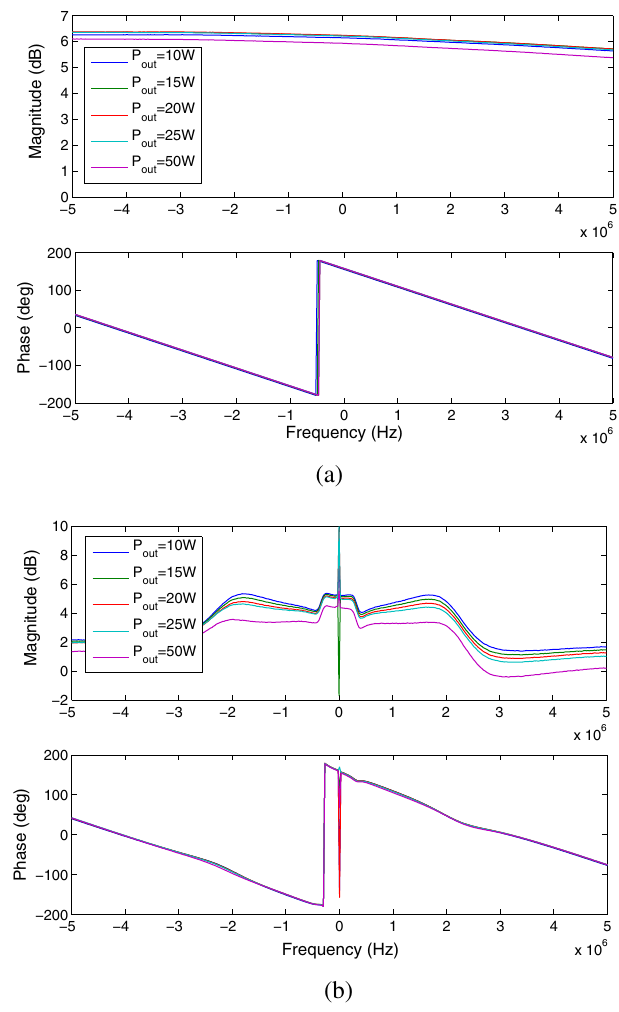
FIG. 14. (Color) Driver transfer functions. (a) Driver amplifier transfer function driven by carrier (large-signal response). (b) Driver amplifier transfer function driven by carrier and modula- tion (small-signal response). The modulation is swept across the band at a level (cid:1) 30 dB below the power carrier at 476